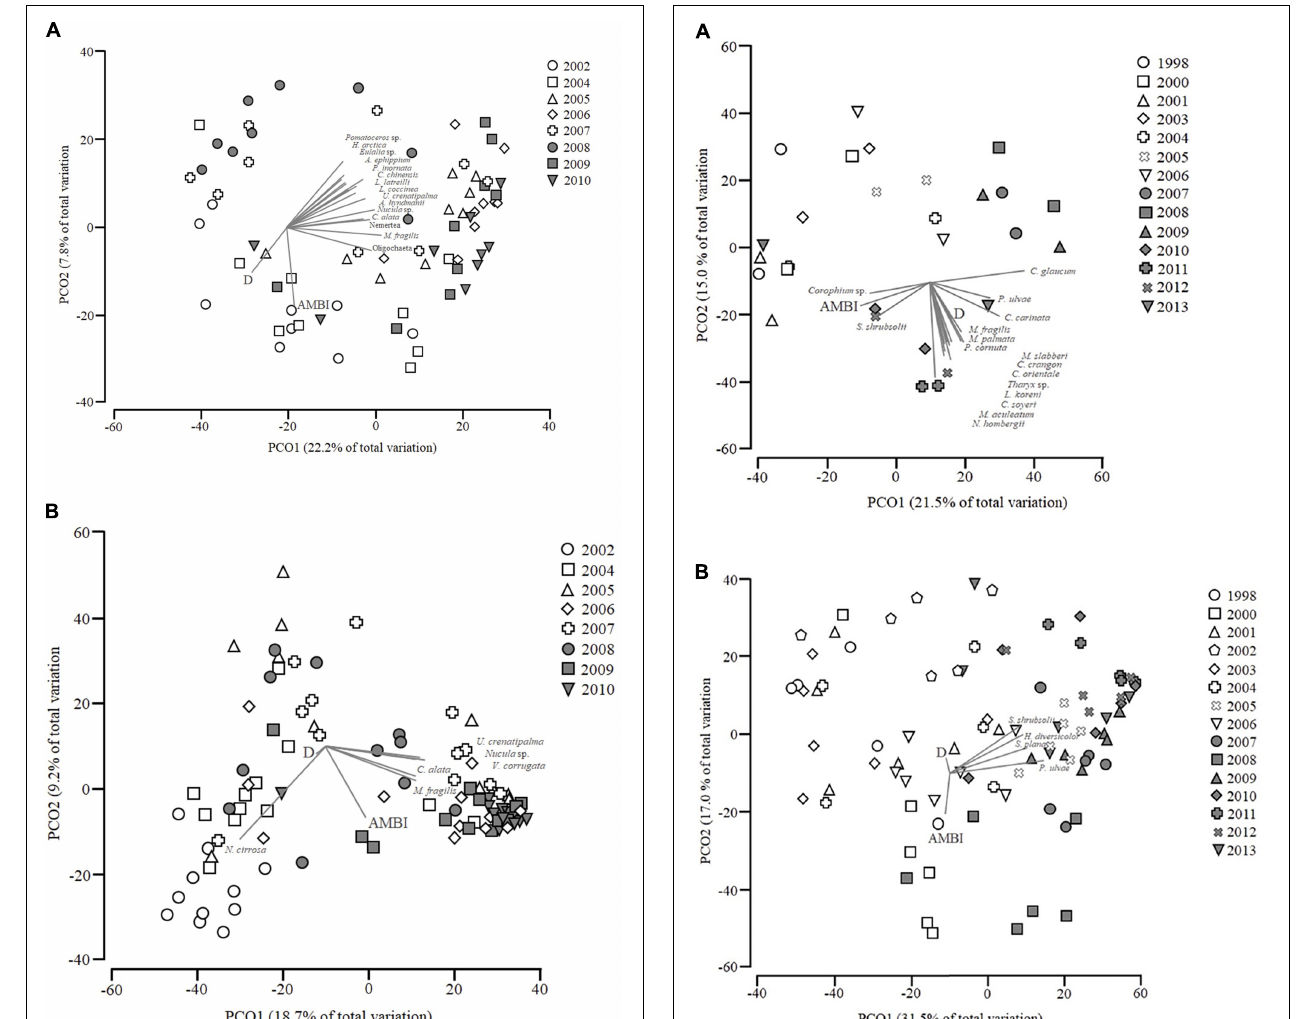
1864), and Nephtys caeca (Fabricius, 1780) are